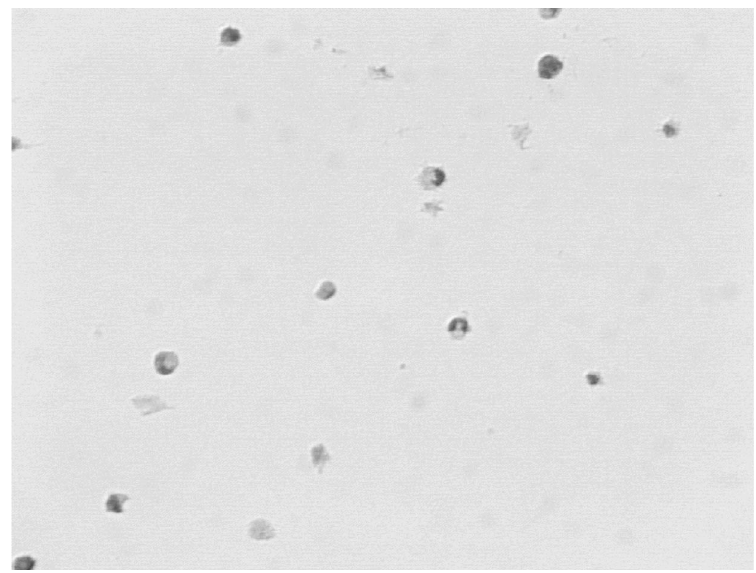
Fig. 1. IHC stained control